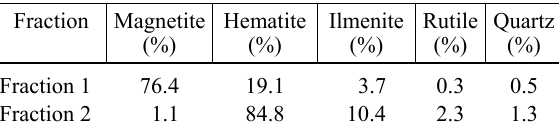
Table 10. Results of the X-ray diffractometry analysis of the magnetic fractions of the Lemme-5 sample